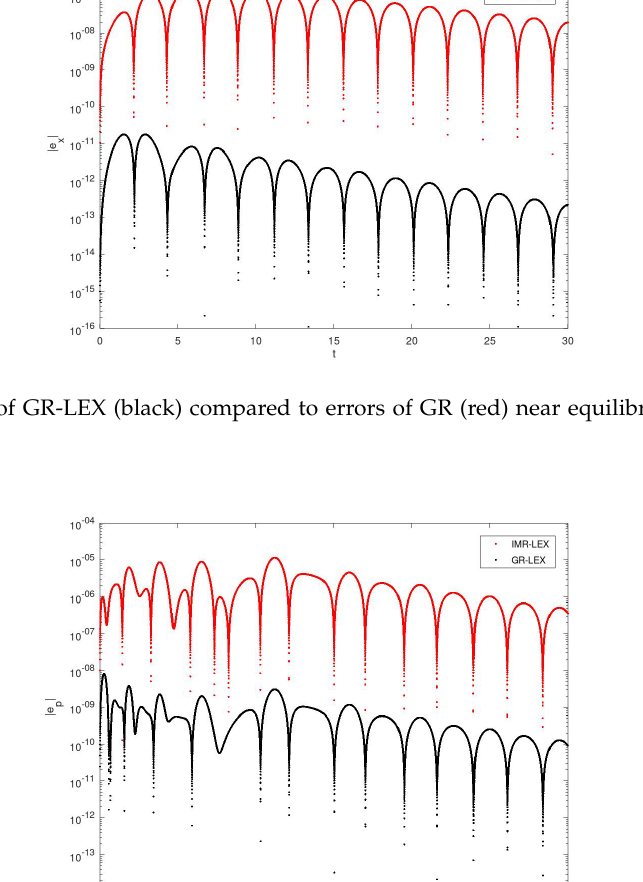
Figure 3. Errors of IMR-LEX (black) compared to errors of IMR (red) near equilibrium: x 0 = 1/ p 0 = 0.05.